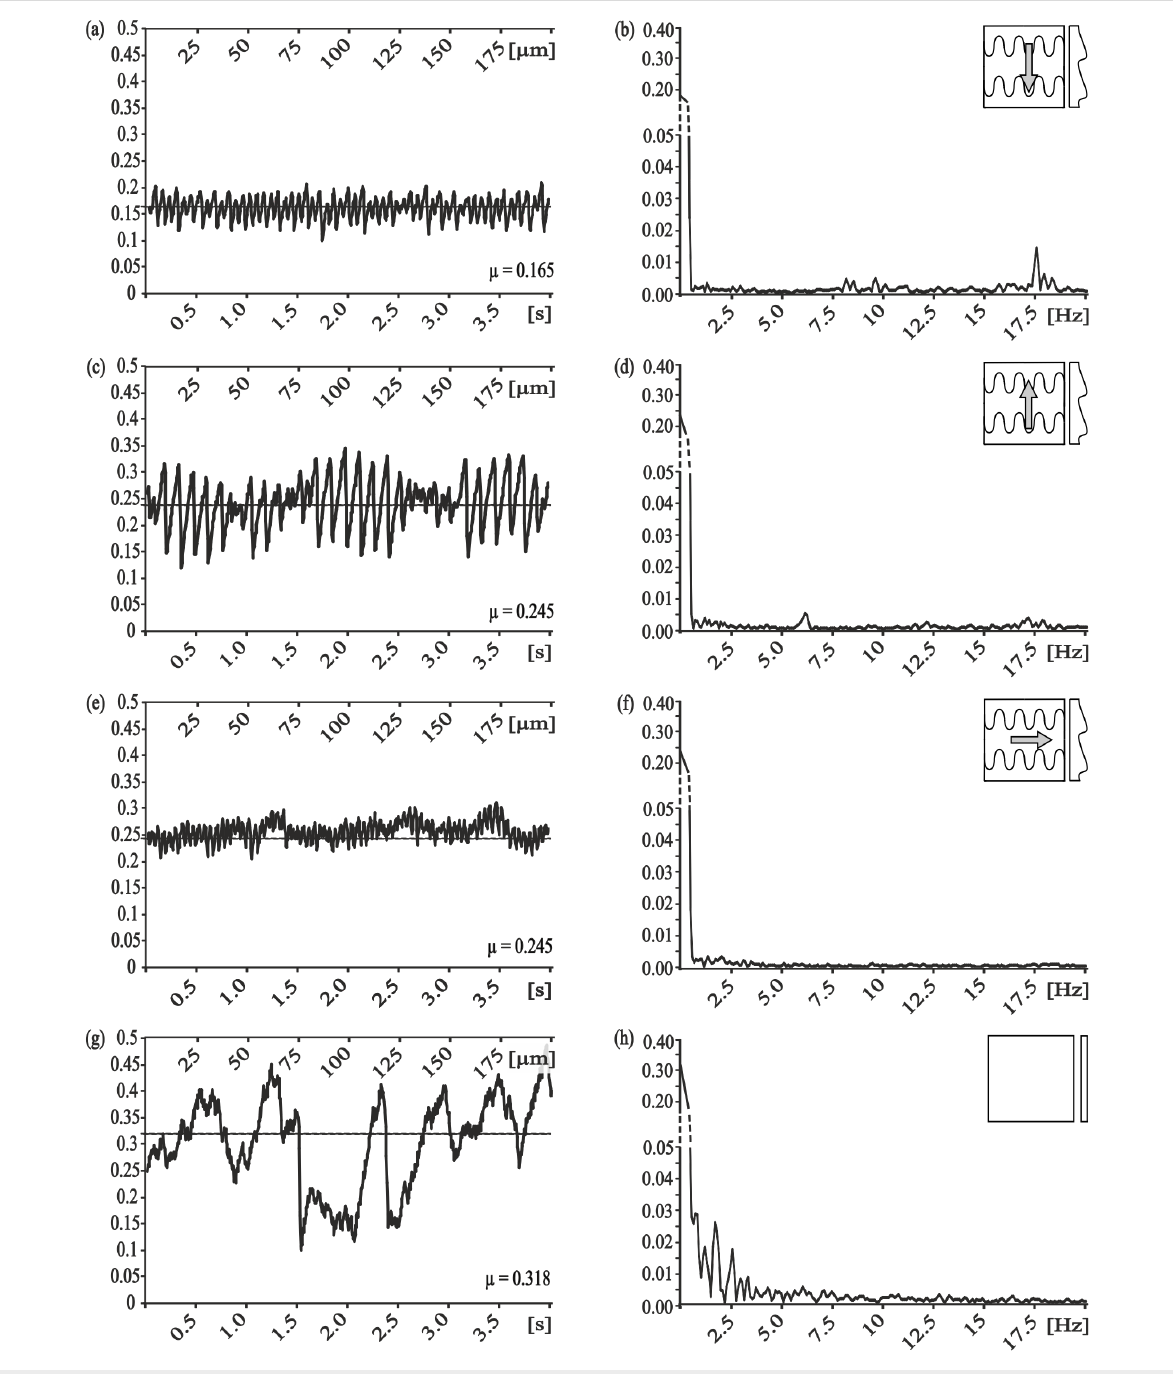
Figure 6: Frequency analysis of the frictional coefficient measured on snake-inspired microstructured polymer surface - SIMPS (a–f) and smooth surface (h,i). Left column, frictional signal in the spatial/time domain. Right column, frictional signal in the frequency domain after FFT; the ordinate shows the single-sided amplitude spectrum - SSAS. Measurement direction: a,b) along the microstructure, c,d) against the microstructure and e,f) lateral to the microstructure, g,h) on smooth surface.